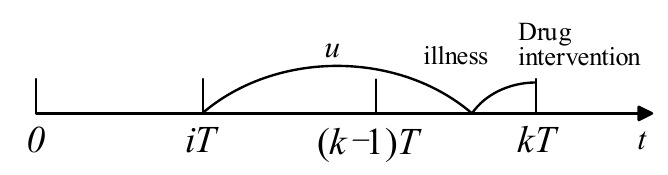
Figure 4. Process of readmission.